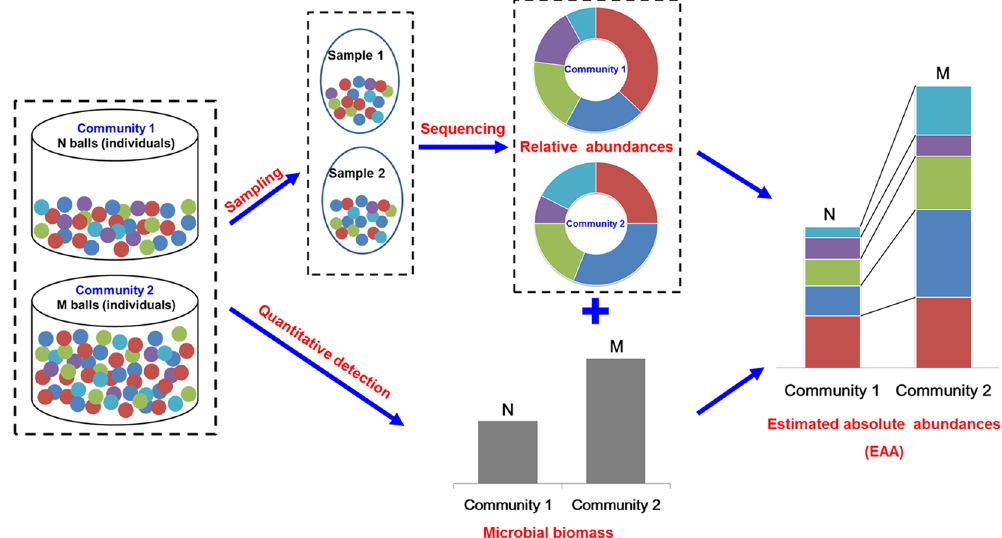
Figure 6. Conceptual model of the relationship between the estimated absolute abundances (EAA) with the relative abundances and the quantitative detection. The total number of balls in each community is quantified as N balls in community 1 and M balls in community 2, where N is about half of M. Meanwhile, the relative abundance of each color of ball is also calculated by regarding each community as an integral whole. The EAA could be obtained by combining the quantitative detection and the relative